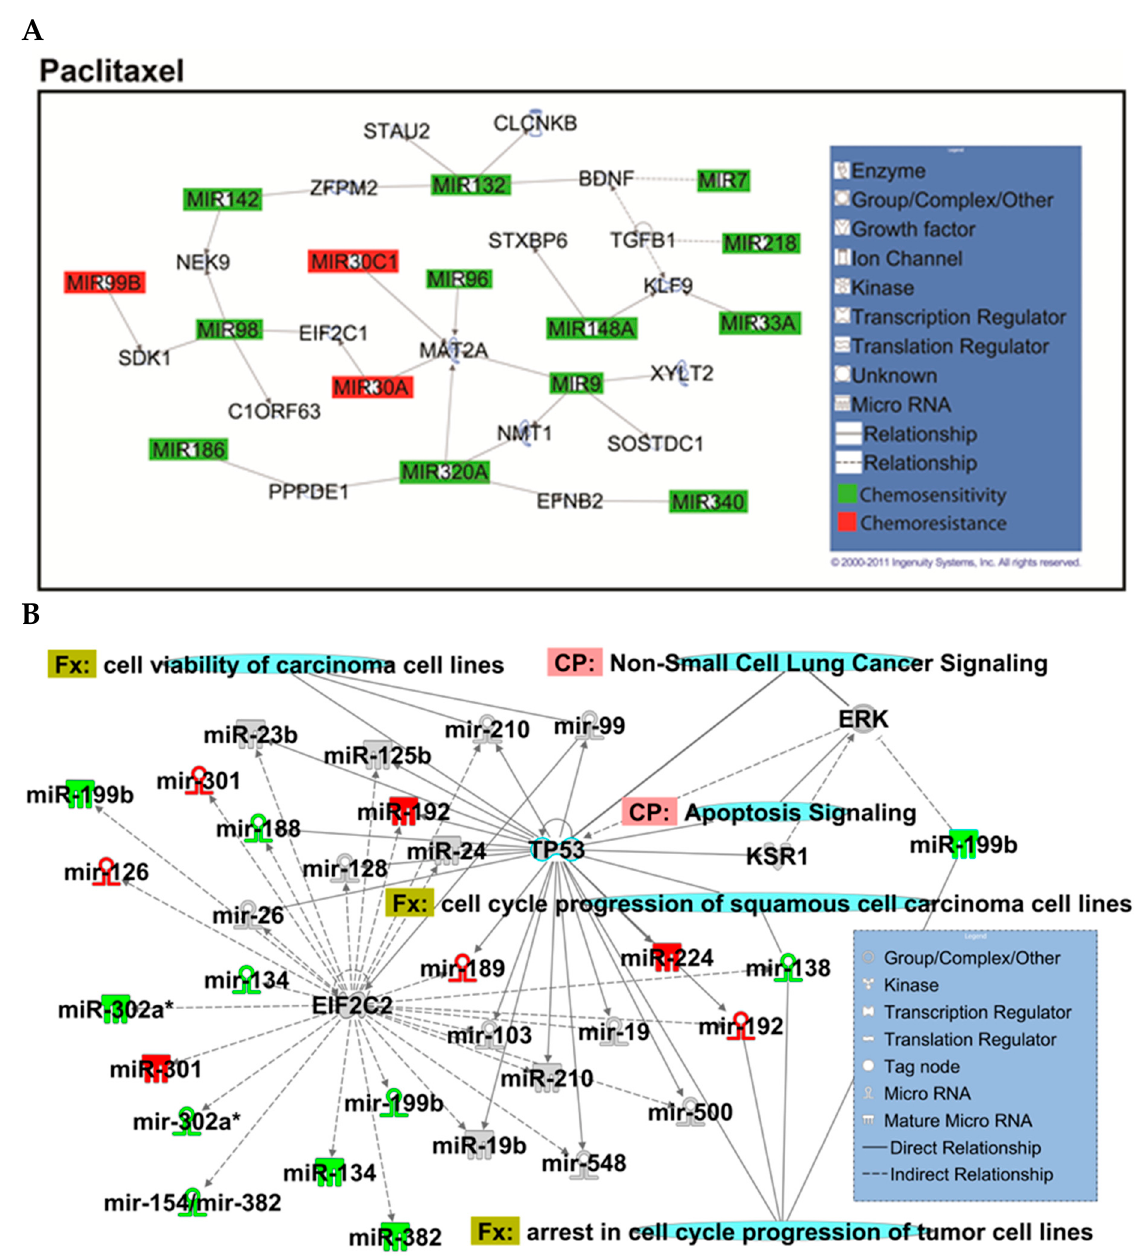
Figure A3. Overview of network derived from IPA Core analysis, representing interactions between miRNAs found to be chemopredictive for paclitaxel and genes relevant to the significant functions and diseases listed in Tables 3 and 4. ( A ) miRNAs and their mRNA target genes. ( B ) Involvement of miRNAs in pathways, functions, and diseases. Canonical pathways (CP:) and functions and diseases (Fx:) as defined by IPA are overlaid to highlight the interconnectedness of the set with molecular processes relevant to chemoresponse. Predictive miRNAs whose expression was positively associated with survival are shown in green, and those whose expression was negatively associated are shown in red.